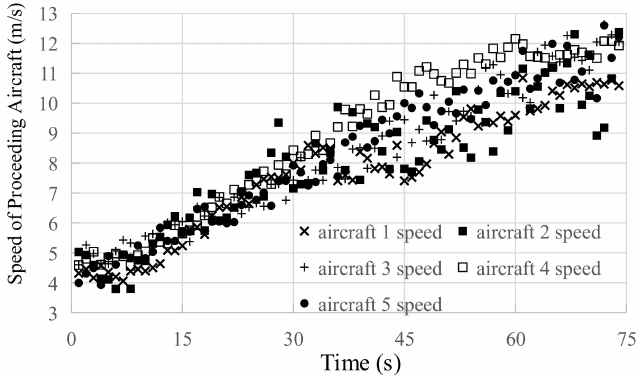
Figure 10. The Taxiing Speed of the Proceeding Aircraft, Aircrafts are not the same ones in Figure 9.